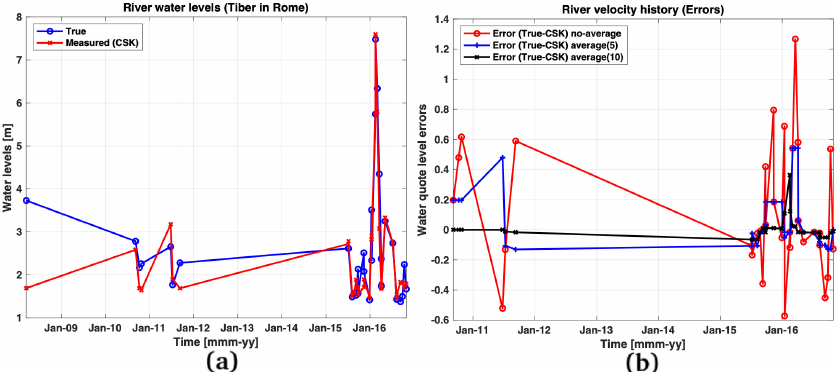
Figure 15. Case study 3 results. ( a ): Ground-station data (red) and satellite observations (blue), versus pixels. ( b ): Water level errors versus time. Blue: CSK versus true. Red: CSK versus true (5 observations average). Black: CSK versus true (10 observations